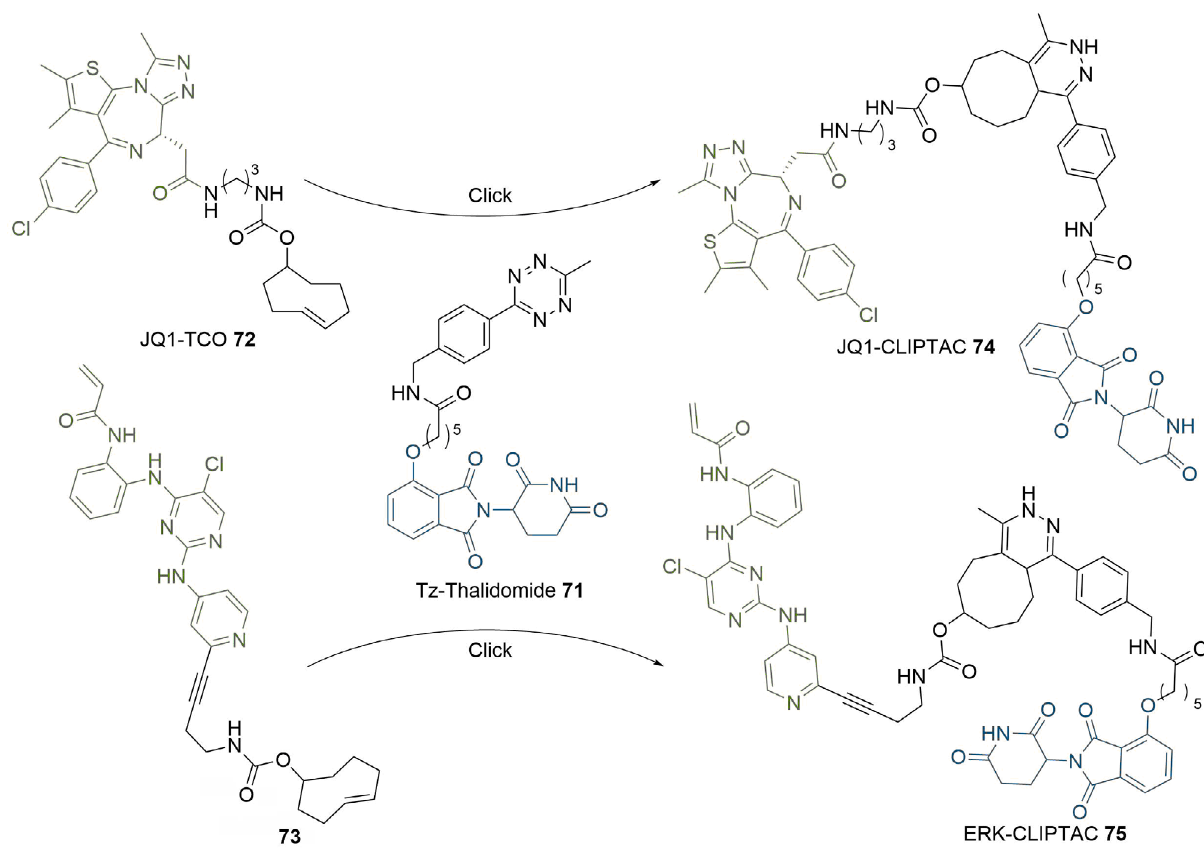
Figure 13. In-situ formation of CLIPTACs 74 and 75 by the click reaction between tetrazine 71 and TCO 72 or 73